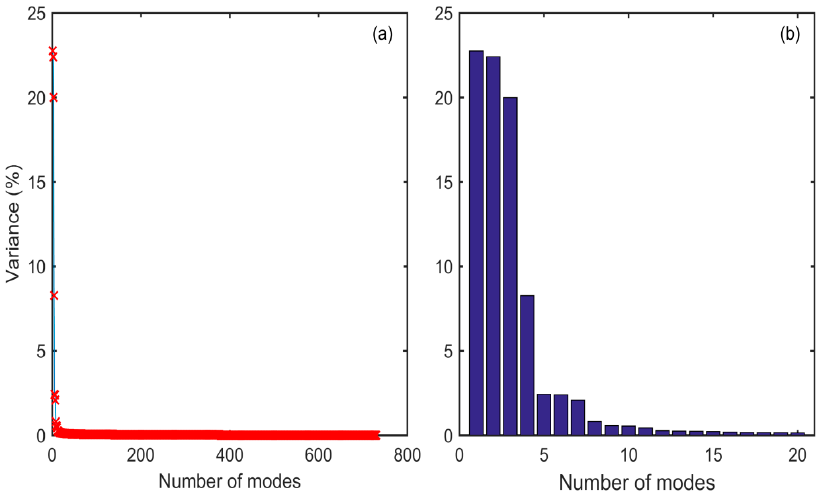
Figure 6. Contribution rate of covariance in KAGA station vertical coordinate ( a ) and contribution rate of its first 20 time patterns ( b ).